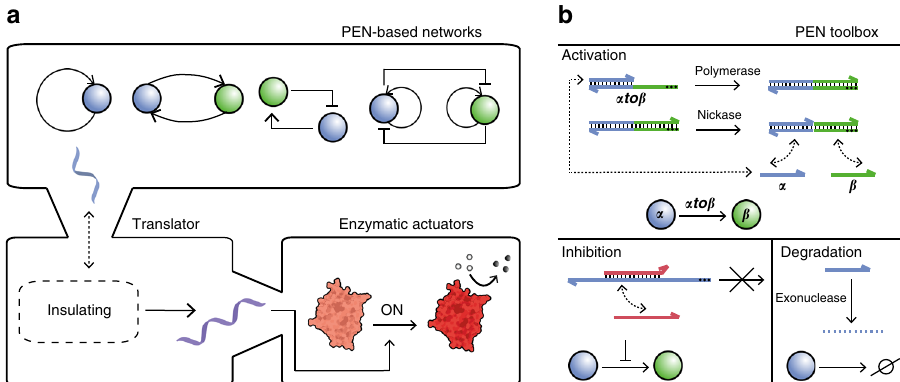
Fig. 1 Controlling enzymatic actuators using dissipative DNA-based circuits. a The dynamics of PEN-based circuits is used to time and control downstream processes. In this work a translator module was designed that translates output strands from the upstream network to unique regulatory DNA strands, which in turn drive enzymatic actuators, while insulating the upstream network from the additional load. b Enzyme-driven DNA-based circuits based on the PEN toolbox comprise three modules, including activation, inhibition, and degradation. Activation is achieved by binding of input ssDNA signals (e.g., primer α ) to their target template (e.g., α to β ), which enables DNA polymerase to extend the oligomer-template pair, followed by nicking of the elongated strand. This results in the return of the input ssDNA signal and a newly formed output ssDNA (e.g., oligomer β ), which dissociate from the template because these reactions are performed around the melting temperature of the partial duplexes. The activation of templates can be inhibited by ssDNA strands that are complementary to part of the template ’ s sequence, and possess a two-base mismatch at their 3 ′ -ends which prevents extension of the partial duplex, rendering the template strand inactive. Finally, signal and inhibition strands are degraded over time by exonuclease. The template strands are protected from degradation by 5 ′ -end phosphorothioate backbone modi fi cations indicated by the black